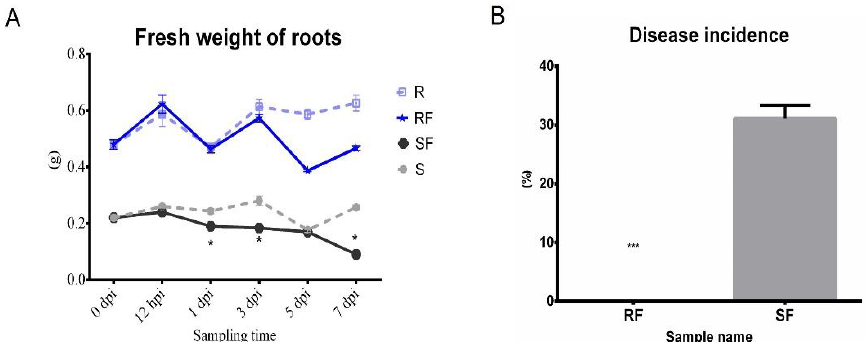
Figure 2. Comparison analysis fresh weight of roots and Fusarium wilt disease occurrence on different watermelon varieties after FON inoculation: ( A ) Comparison analysis of fresh weight of roots in different samples; ( B ) Comparison analysis of disease incidence in different samples. S, Susceptible cultivar + mock-inoculation control (H 2 O 2 ); R, Resistant cultivar + mock-inoculation control (H 2 O 2 ); SF, Susceptible cultivar + FON; RF, Resistant cultivar + FON. Moreover, 0 dpi (before treatment); 12 hpi (12 h post inoculation); 1 dpi (1 day post inoculation); 3 dpi (3 days post inoculation); 5 dpi (5 days post inoculation); 7 dpi (7 days post inoculation). Data were expressed as mean ± SE ( n = 3). Multiple t tests of Two-way ANOVA (*, p ≤ 0.001).